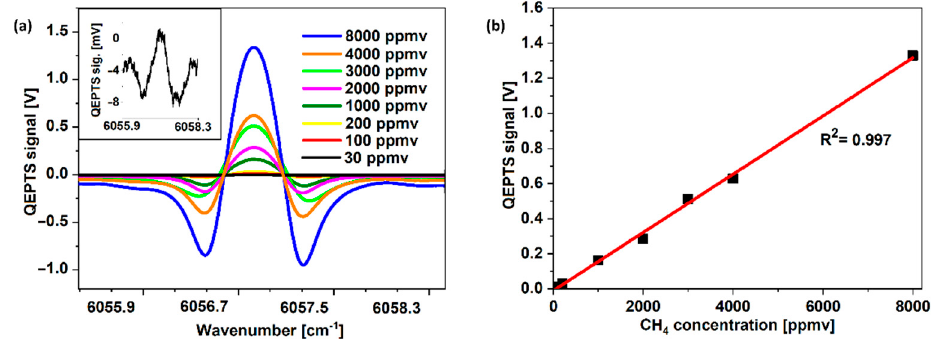
Figure 7. ( a ) Full 2f-WMS scans across the CH 4 absorption line registered for concentrations listed in the graph (pressure of gas on the inlet of fiber during registration: 25 Torr over atmospheric pressure). ( b ) Maximum 2f-WMS amplitude plotted as a function of CH 4 concentration showing the linearity of the response of the proposed sensor configuration. The obtained R 2 value is listed on the graph.